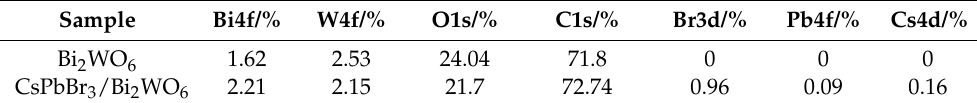
Figure 2. XPS spectra of (1) pure Bi 2 WO 6 and (2) 15 wt% CsPbBr 3 /Bi 2 WO 6 samples. ( a ) Survey scan; ( b ) W4f; ( c ) Bi4f; ( d ) O1s. Table 1. Relative atomic content of pure Bi 2 WO 6 and 15 wt% CsPbBr 3 /Bi 2 WO 6 samples.